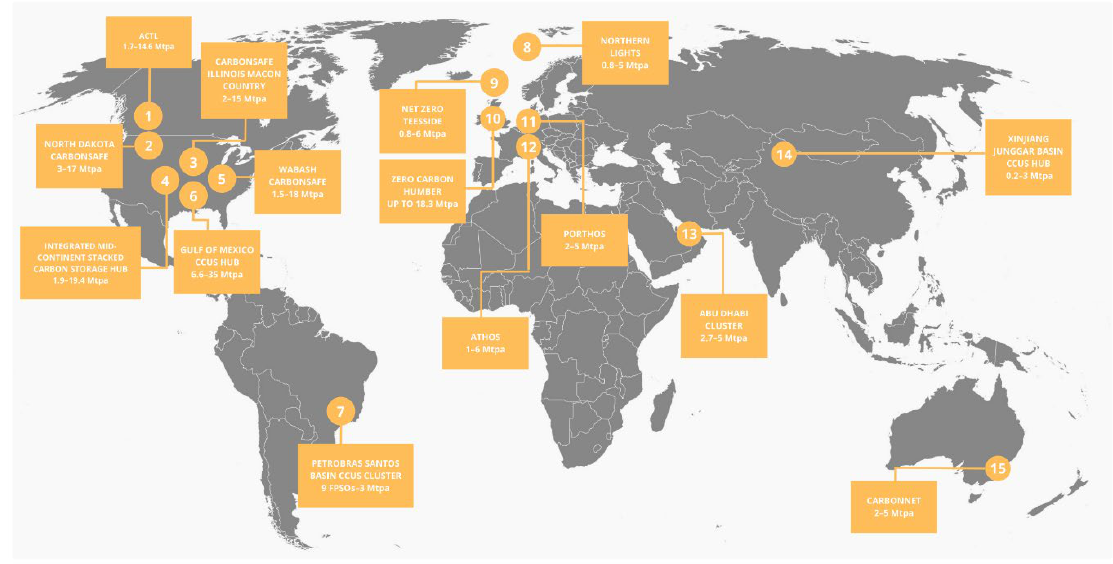
Figure 8. Map of CCUS hubs described in the paper.